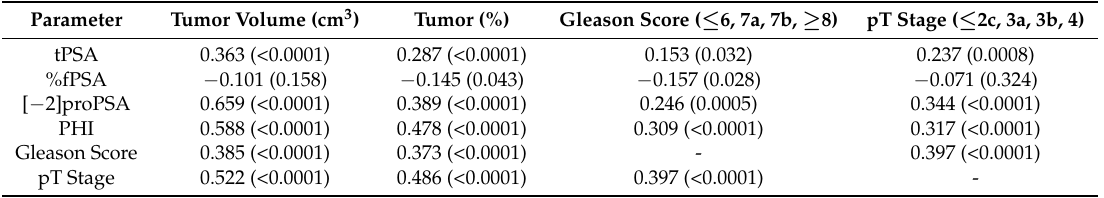
Table 4. Pearson correlation of the serum parameters and the pathology findings.